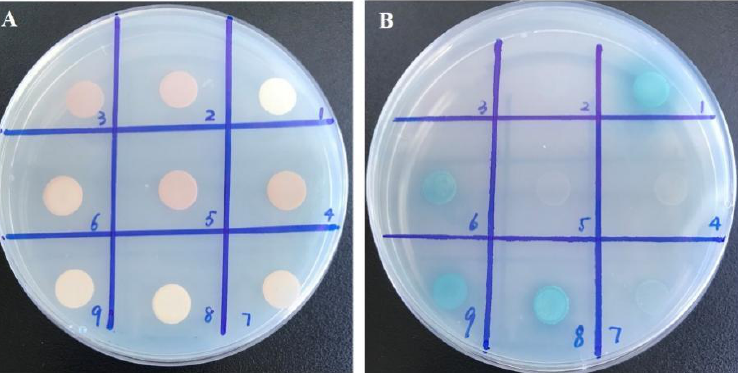
Figure 4. MaTGA8 interacts with MaNPR3, MaNPR4, and MaNPR11. Control ( A ); mutual verifica- fication ( B ); 3, 4, 5, and 6: auto-activation of pGADT7-NPR3, pGADT7-NPR4, pGADT7-NPR11,